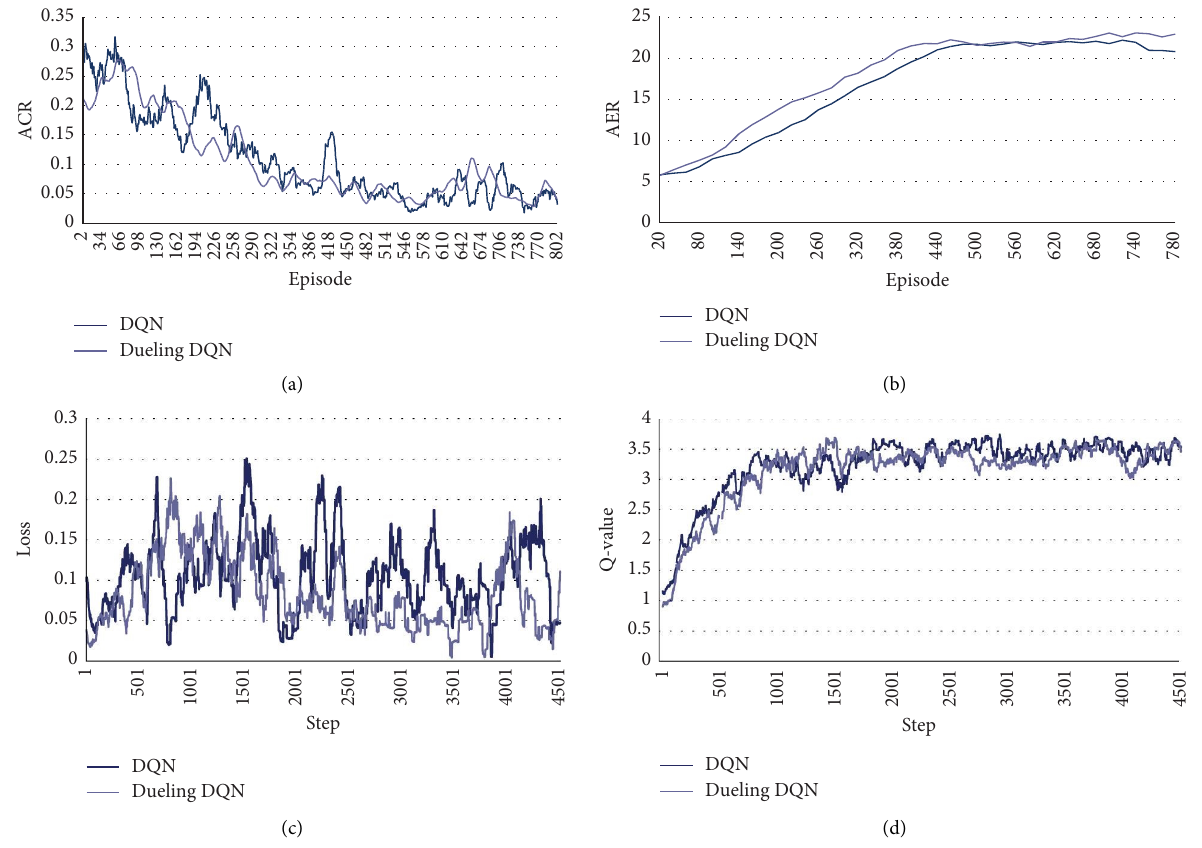
Figure 9: Performance comparison between DQN and Dueling DQN. (a) ACR. (b) AER.(c) Loss. (d) Q-value.